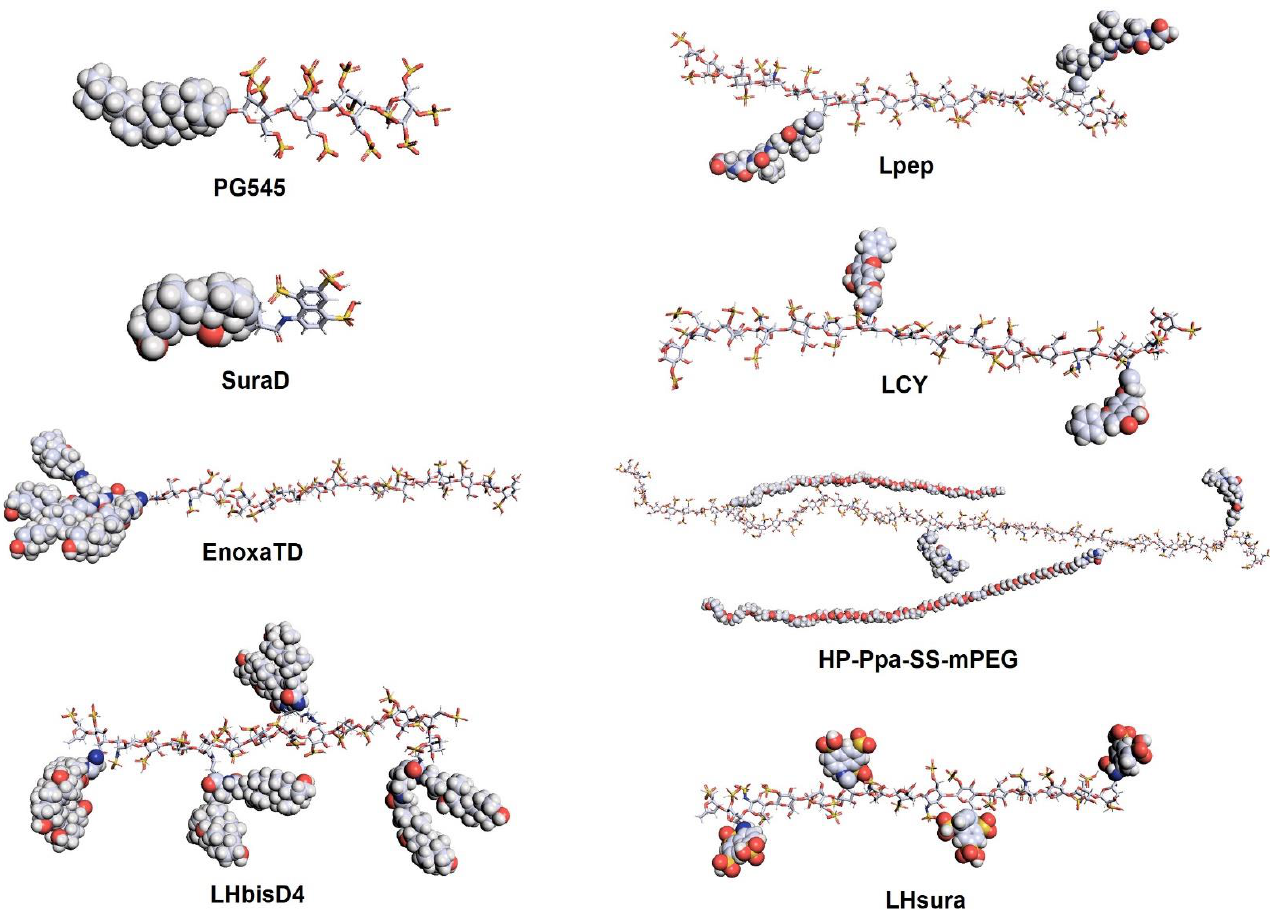
Figure 3. Chemical structures of recently studied heparin conjugates and heparin-mimic biomolecules. Heparin or the heparin-mimic moiety in the molecule is expressed as a stick, while the conjugate is expressed as a sphere. The molecular structures were visualized using the PyMOL (the PyMOL Molecular Graphics System, Version 2.5.0, Schrödinger) program. SuraD, suramin fragment and deoxycholic acid conjugate; EnoxaTD, enoxaparin and TetraDOCA conjugate; LHbisD4, LMWH and bisDOCA conjugate; Lpep, LMWH and peptide conjugate; LCY, LMWH and chrysin conjugate; HP-Ppa-SS-mPEG, PEG-detachable pyropheophorbide-a (Ppa)-functionalized heparin; LHsura, LMWH, and suramin fragment conjugate. Table 1. Recently developed heparin-based biomolecules for the treatment of various diseases.